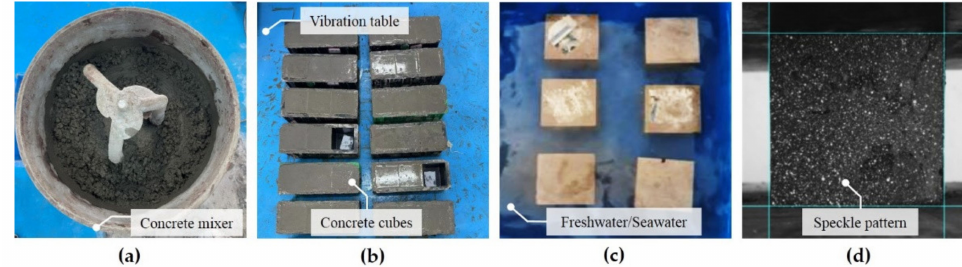
Figure 1. Fabrication and preparation of seawater concrete specimen. ( a ) Stirring, ( b ) filling and vibration, ( c ) curing of the cube concrete specimens, and ( d ) preparation of specimen for DIC measurement with speckle pattern sprayed on the front surface of